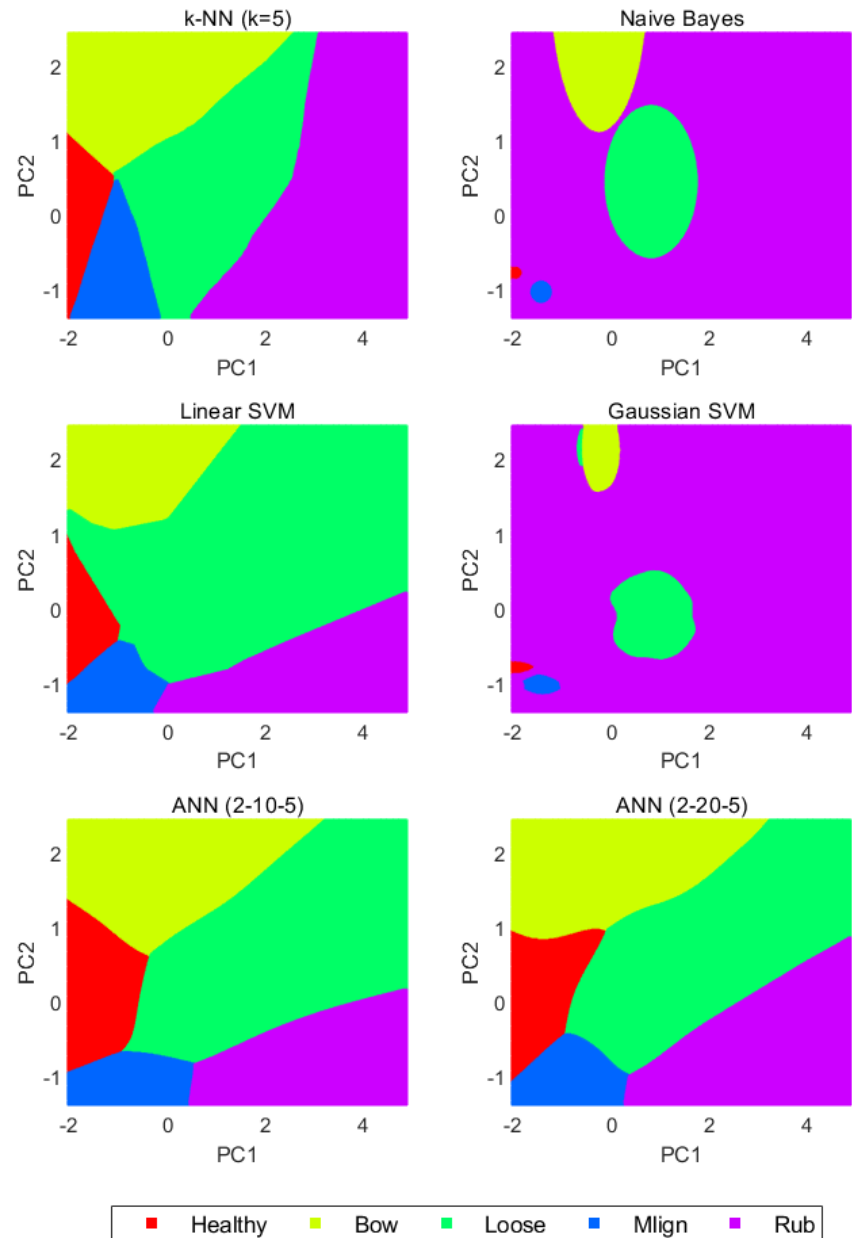
Figure 9. Visualised decision rules for the standardised SE at 40 Hz.